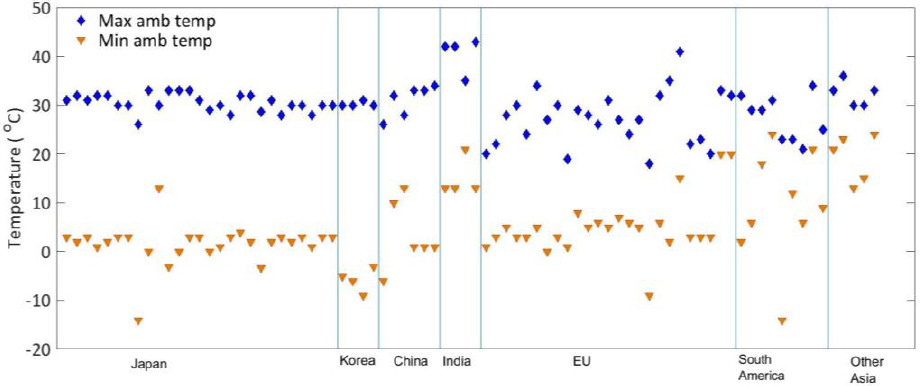
Figure 11. Maximum and minimum ambient air temperatures around the world.